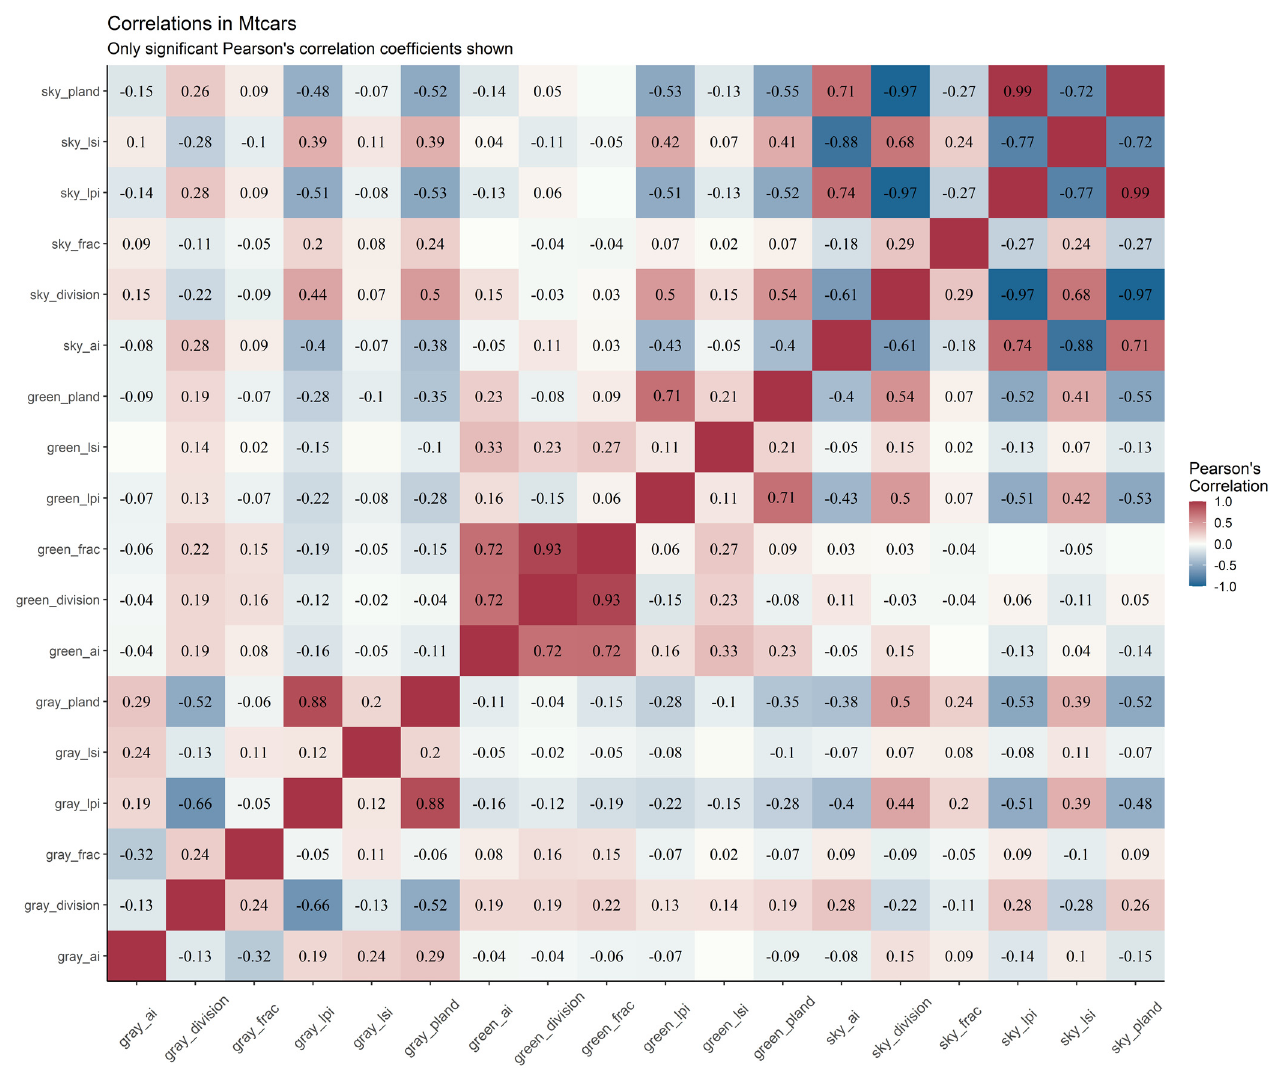
Figure 8. The relationships between different landscape indicator.